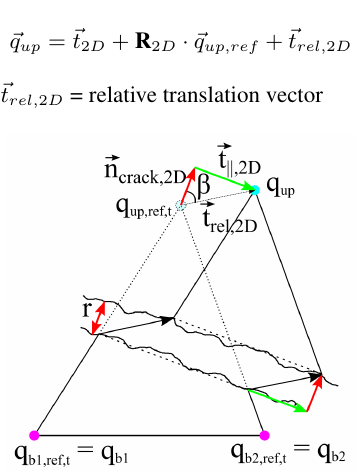
The Helmert parameters (cid:126)t 2 D , R 2 D can be computed with the coordinates of base line vertices in the reference and the de- formed state.